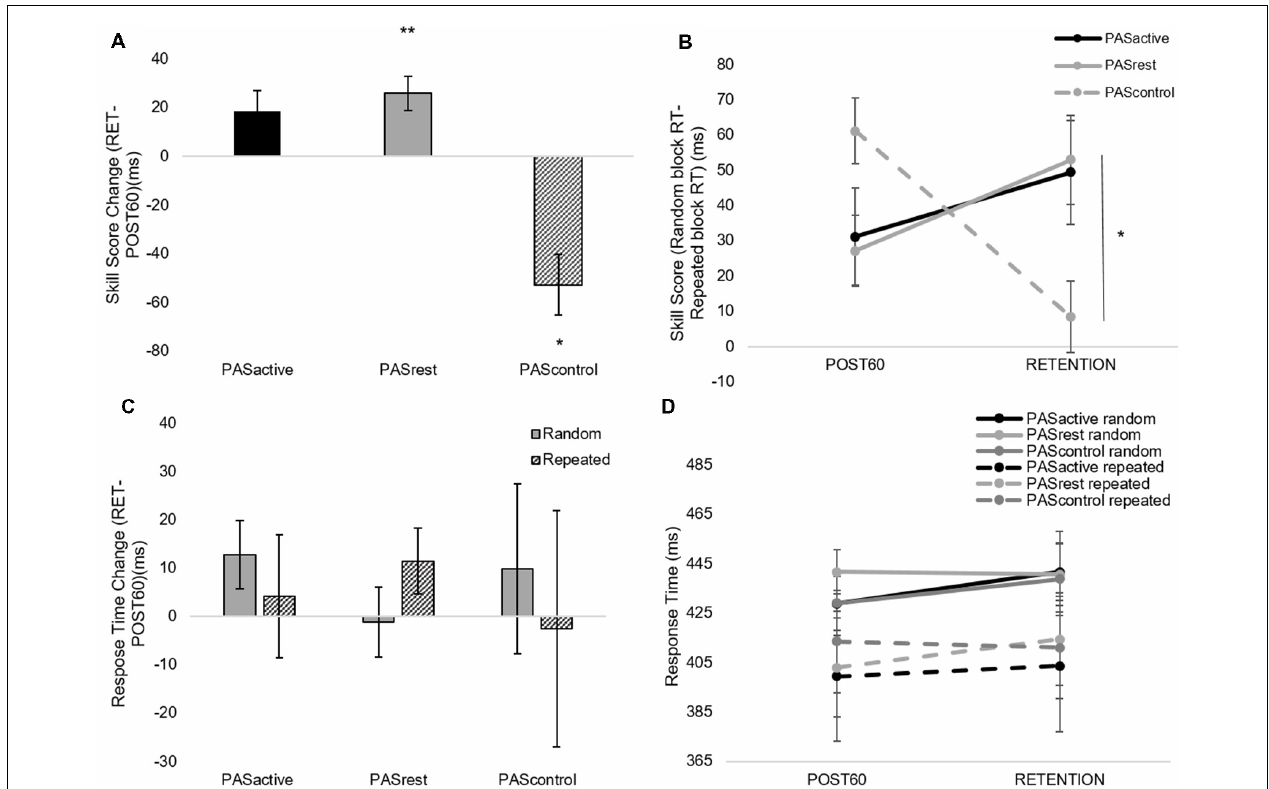
FIGURE 6 | Skill score (A,B) and random block RT (C,D) calculated from SRTT performance (mean ± SE) during PAS ACTIVE , PAS REST ,and PAS CONTROL conditions at POST60 and RETENTION time points. There was a condition-by-time interaction for skill score ( F ( 2,50 ) = 4.31, p = 0.02). At retention, skill score following PAS REST was greater than that following PAS CONTROL ( ∗ p < 0.05) with no significant change following PAS ACTIVE ( p = 0.10). Skill score increased following PAS REST ( ∗∗ p < 0.01) and decreased following PAS CONTROL ( ∗ p < 0.05). (C,D) PAS condition did not significantly affect retention of general motor performance on the